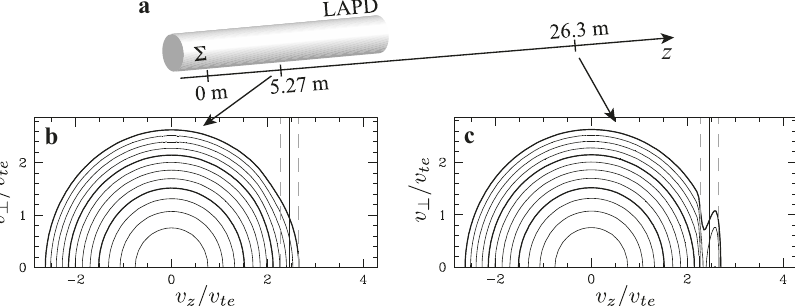
Fig. 4 Liouville mapping over an extended region. a The Liouville mapping domain is extended beyond the length of the LAPD. Logarithmically spaced contours of the electron velocity distribution predicted by Liouville mapping b at the point of measurement at z = 5.27 m and c at a point fi ve times further away (beyond the length of the LAPD experimental chamber) at z = 26.3 m, showing that with a longer interaction distance, a clear accelerated beam of electrons is visible. The vertical solid black line in ( b , c ) represents the resonant velocity. Vertical dashed lines indicate the nonlinear trapping